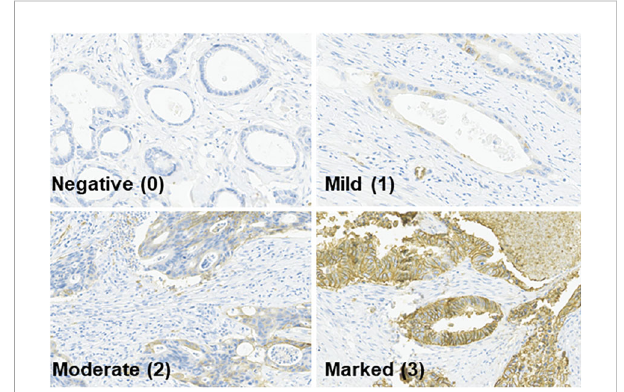
FIGURE 1 Immunohistochemical staining intensity of GLUT-1